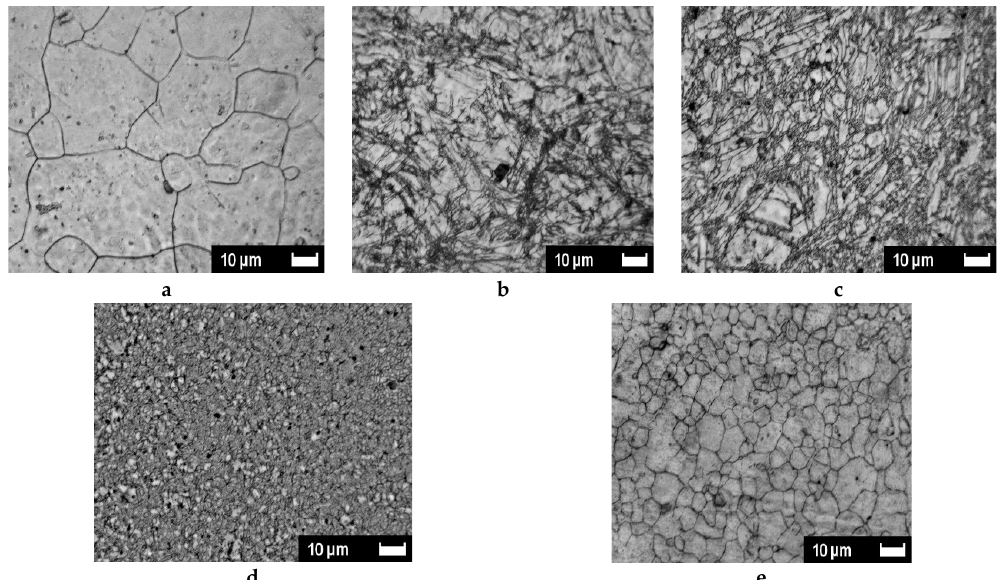
Figure 12. Microstructure versus temperature of AZ31 billets after 2 B C ECAP passes: ( a )—as received, ( b )—150 ◦ C, ( c )—200 ◦ C, ( d )—250 ◦ C, ( e )—300 ◦ C.